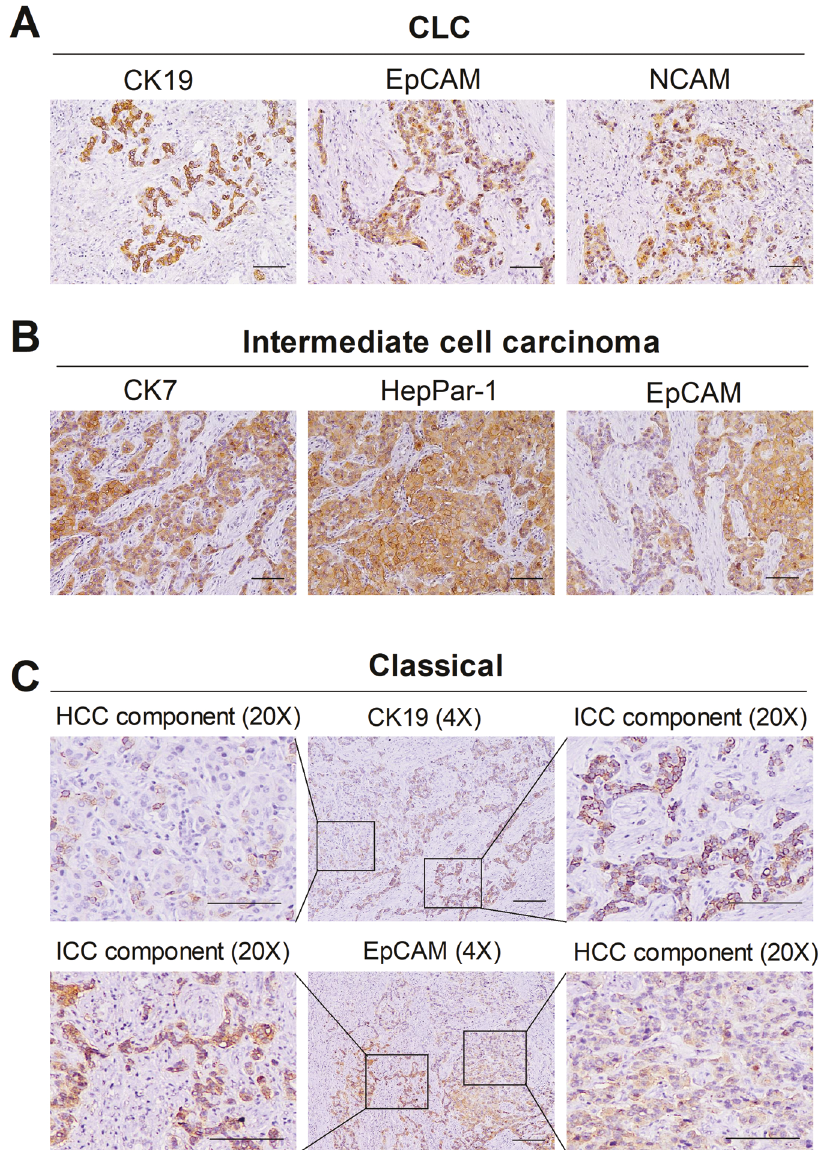
Fig. 3 Immunostaining pro fi le of cHCC-CCA subclasses. Representative positive immunohistochemical staining features observed for A the CLC type, B intermediate cell carcinoma and C the classic type. CLC cholangiolocellular